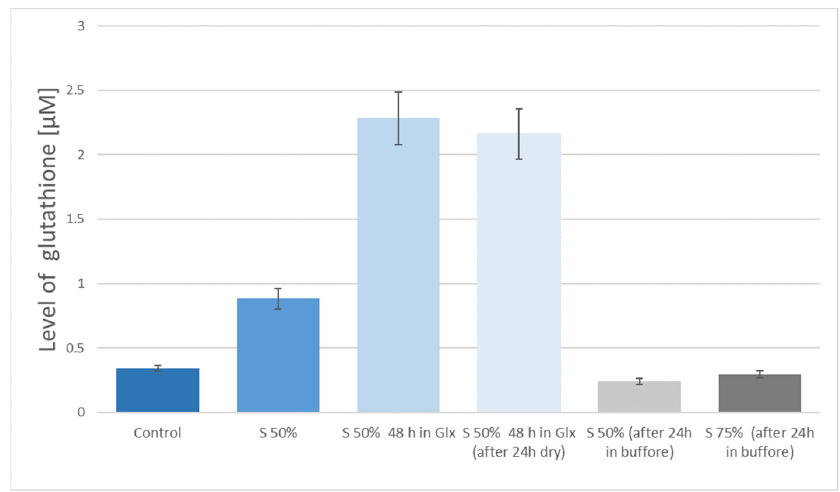
Figure 5. The level of glutathione on the surface of graphene obtained by delamination method and modified by H 2 SO 4 (S50%—50% sulfuric acid, S75%—75% sulfuric acid, Glx—glutathione solution).